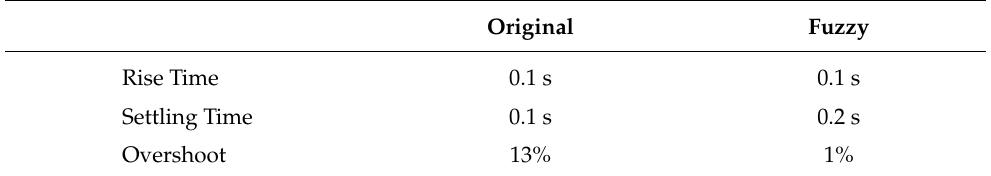
Table 4. Controller performance.